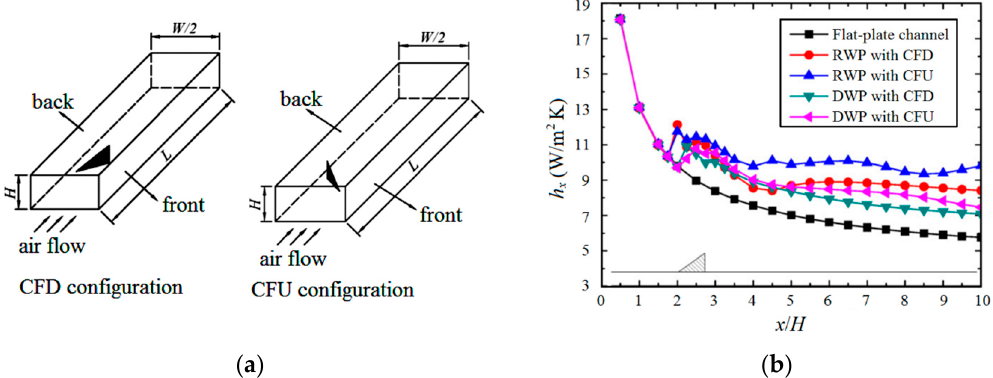
Figure 4. VGs with two different configurations [83]. ( a ) Physical model. ( b ) Variation of span-averaged heat transfer coefficient. CFD: common-flow-down; CFU: common-flow-up. RWP: rectangular winglet pair; DWP: delta winglet pair.